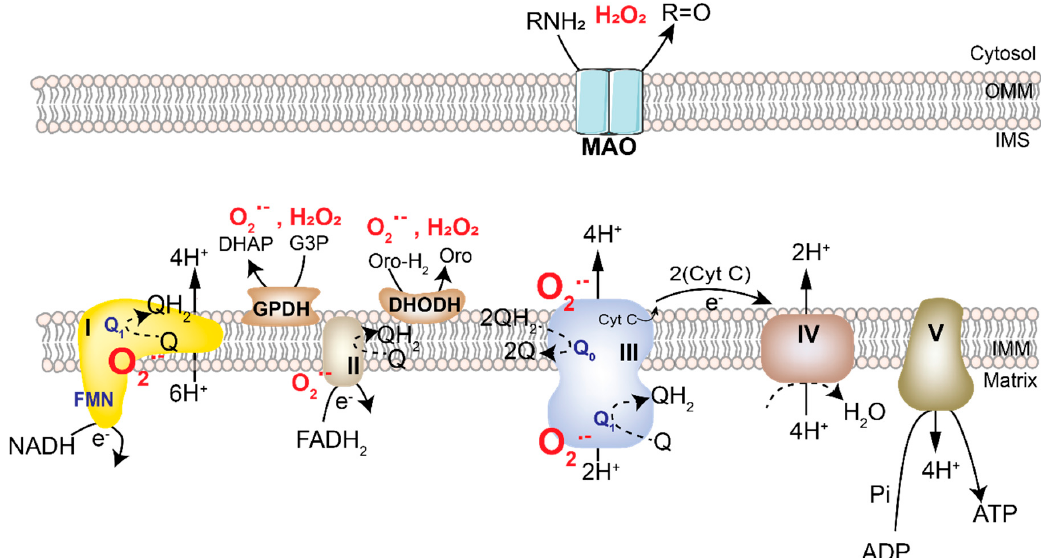
Figure 2. Mitochondrial sites that generate ROS. Mitochondria generate cellular energy in the form of ATP via the transfer of electrons through the electron transport chain (ETC), which is a set of multi-protein assemblies known as complexes I–IV. These exist in inner mitochondrial membrane (IMM). NADH and FADH 2 generated in the tricarboxylic acid (TCA) cycle enter the ETC at complex I and II, respectively, and generate protons and electrons during their conversion to NAD + and